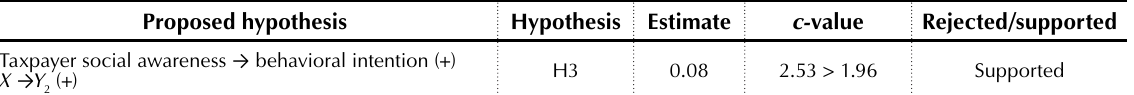
Table 3. Path coefficient for taxpayer social awareness has a positive and significant effect on behavioral intention for taxpayer compliance